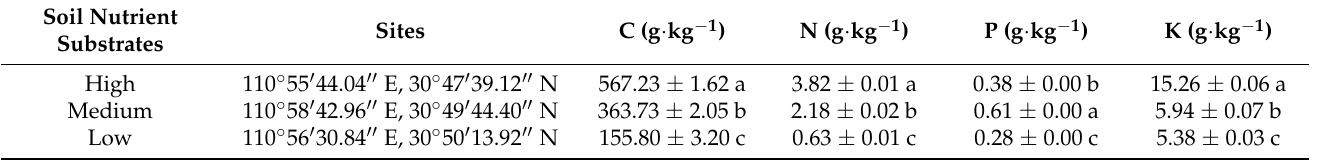
Table 1. Initial soil chemistry of the three sites of Pinus massoniana Lamb.